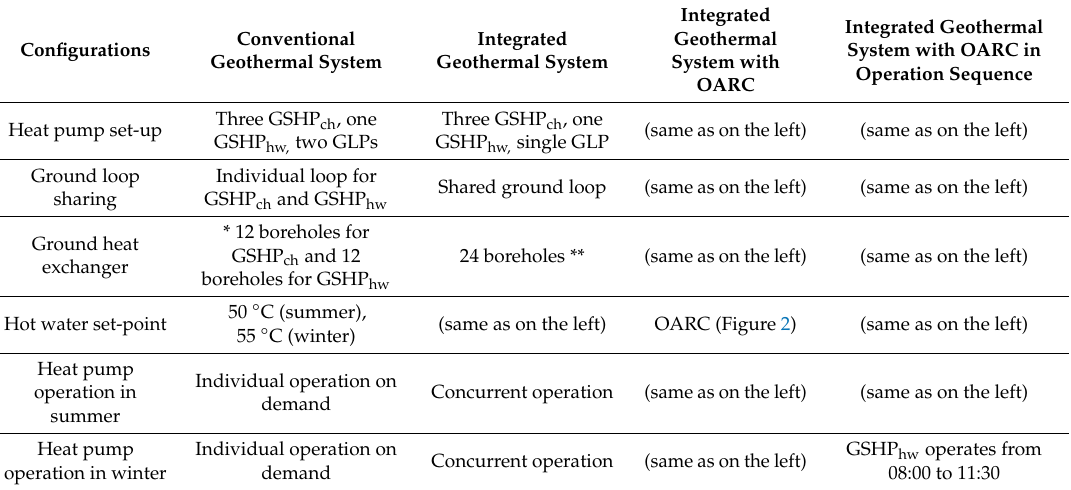
Table 2. Modeling setup of the four system